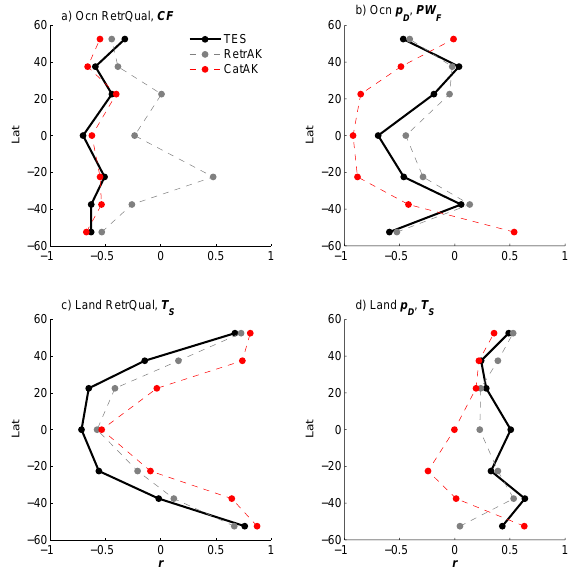
Fig. 17. Correlation between retrieval quality and p D (height of peak HDO sensitivity) with primary predictor variables over dif- ferent